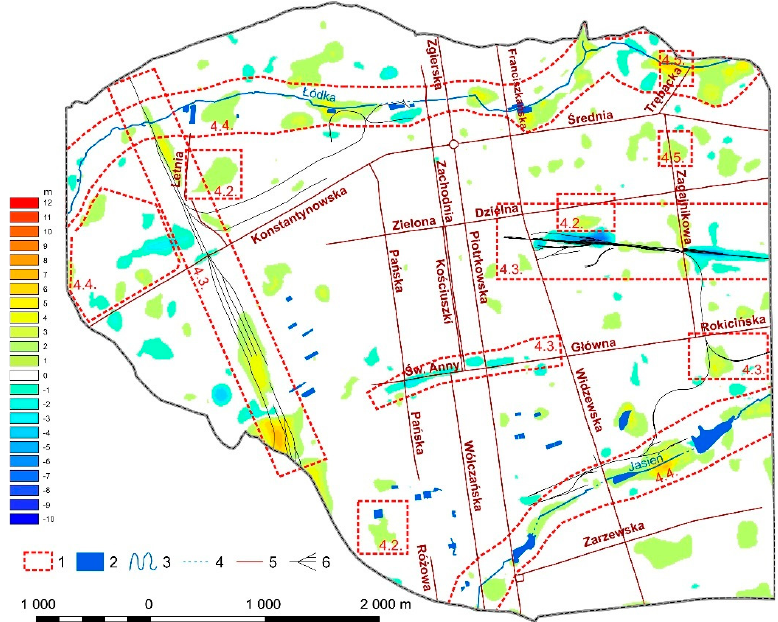
Figure 9. Changes in the relief of a part of Ł ód ź against selected elements of the environment and the city’s infrastructure as of 1917. 1—areas of detailed analysis, 2—waters, 3—surface water- courses, 4—underground watercourses, 5—main streets, 6—railway tracks (situation in 1917). Source: Own